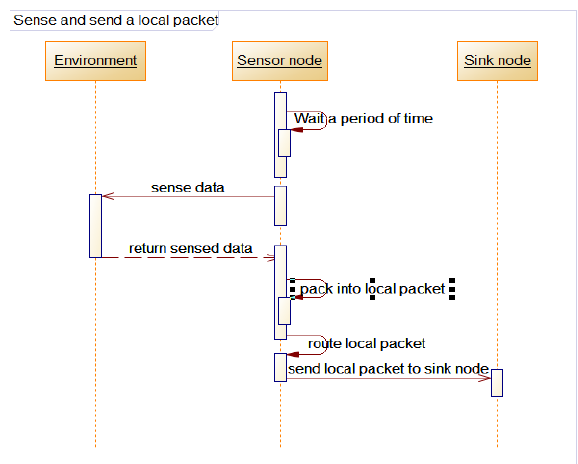
Figure 12. Procedureof sensingand sendinga packet.